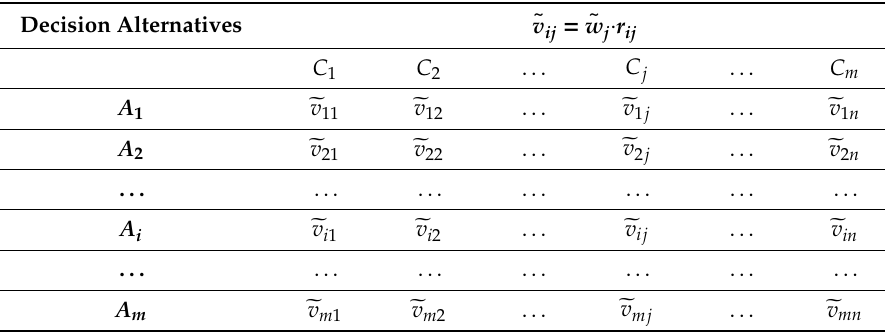
Table 6. Fuzzy Weighted Decision Matrix